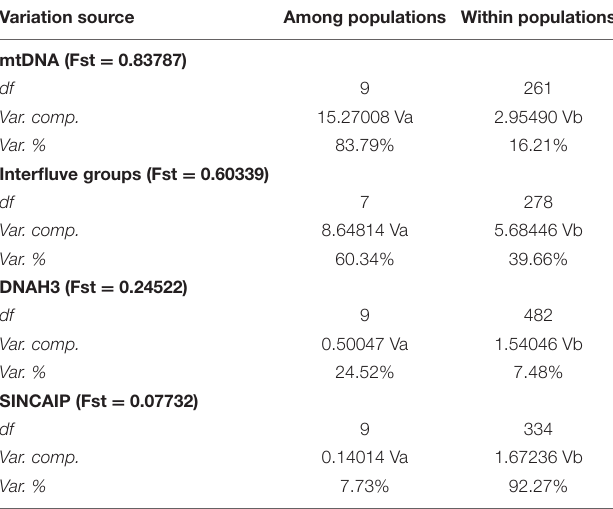
TABLE 1 | Summary statistics of molecular variance (AMOVA) comparing variation among and within phylogenetic clades/populations and comparing variation among and within different interfluve